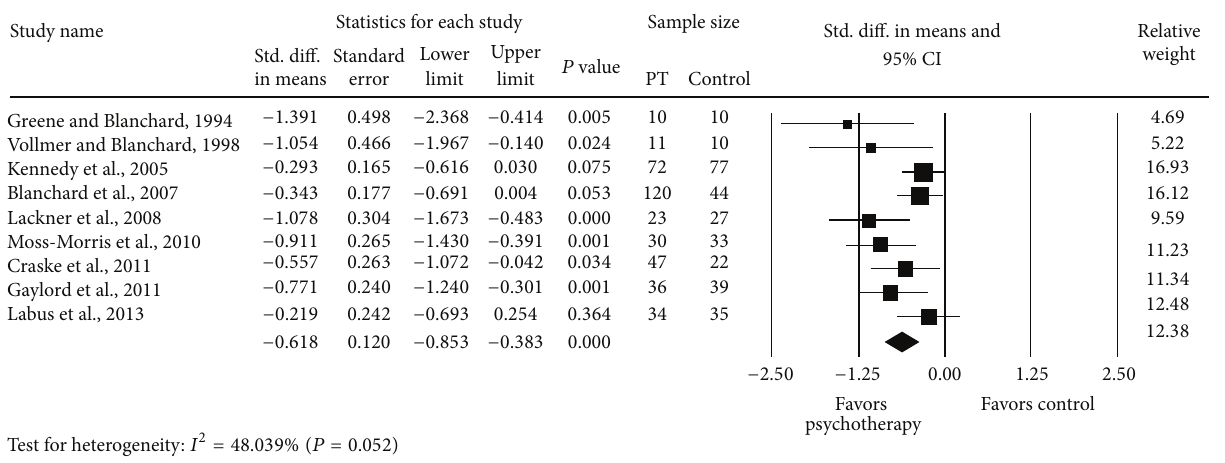
Figure 2: Forest plot for composite IBS symptoms severity scales in RCTs of psychotherapy (PT) versus control.